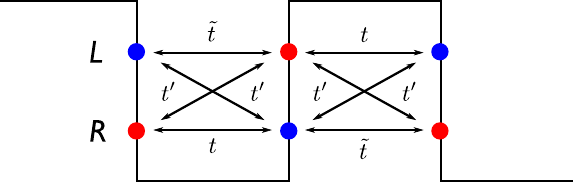
FIG. 2. The coupling t , ˜ t , and t 0 between the neighboring domain-wall modes.